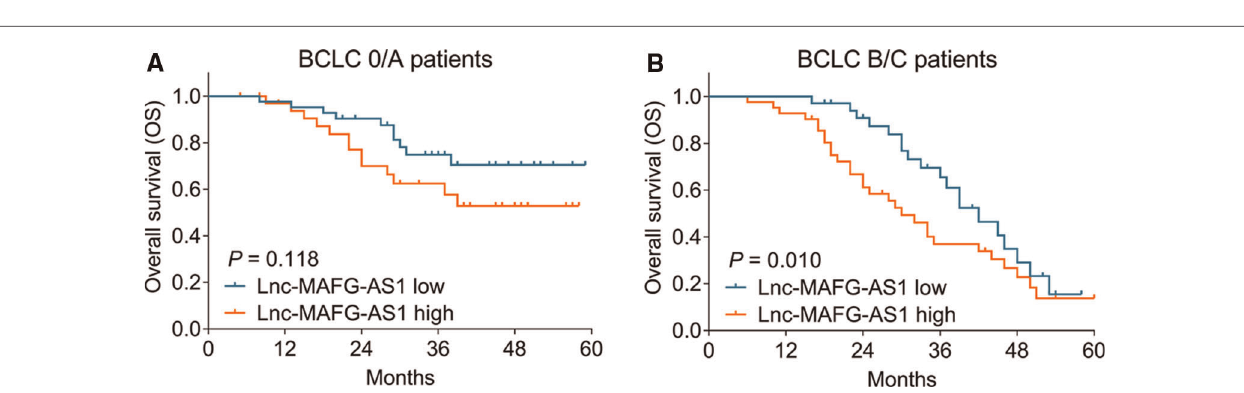
FIGURE 3 | Prognostic factors relating to OS. Univariate ( A ) and multivariate ( B ) Cox ’ s proportional hazards regression analysis of prognostic factors relating to OS.